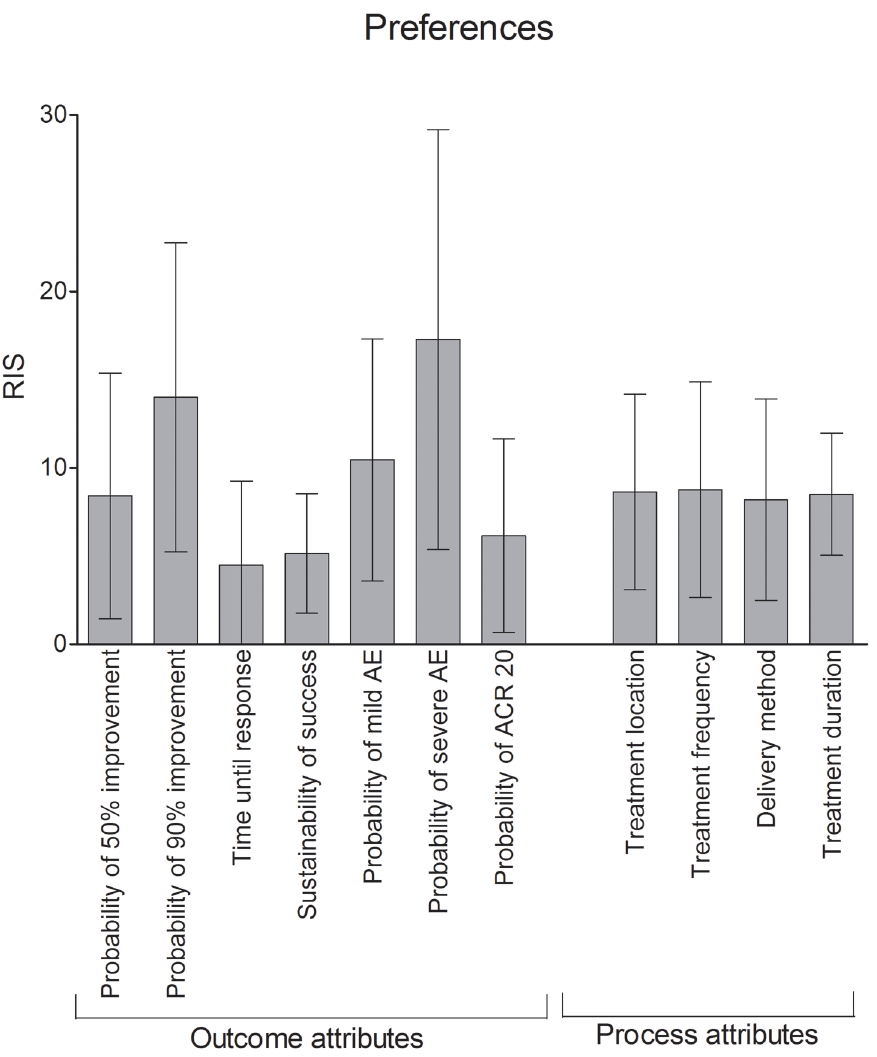
Time until response (RIS = 4.5) and sustainability of the therapeutic success (RIS = 5.2) were least relevant. Bars: Means with standard